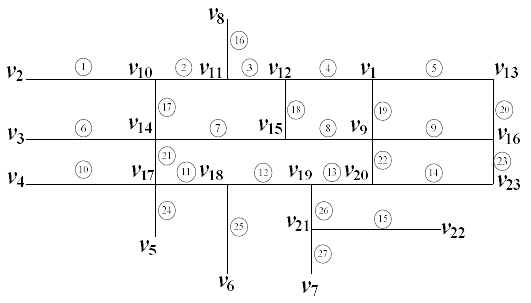
Figure 2. Transportation network. Table 6. Number of vehicles available at rescue points.